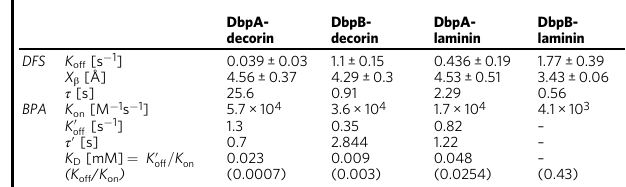
Table 1 Quanti fi cation of obtained parameters with dynamic force spectroscopy (DFS) and binding probability assay (BPA)